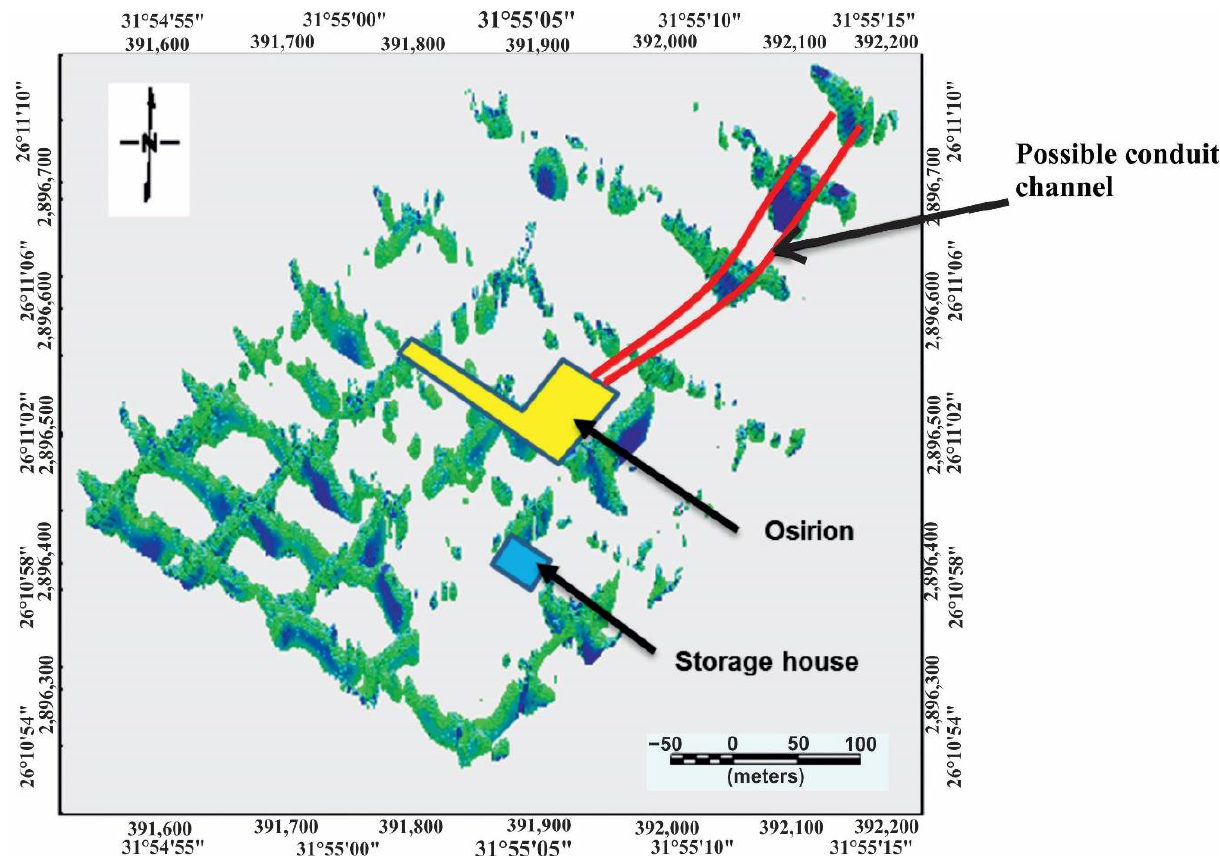
Figure 13. A 3D displays of the muddy sand-bearing water and locating the possible conduit channel at the study